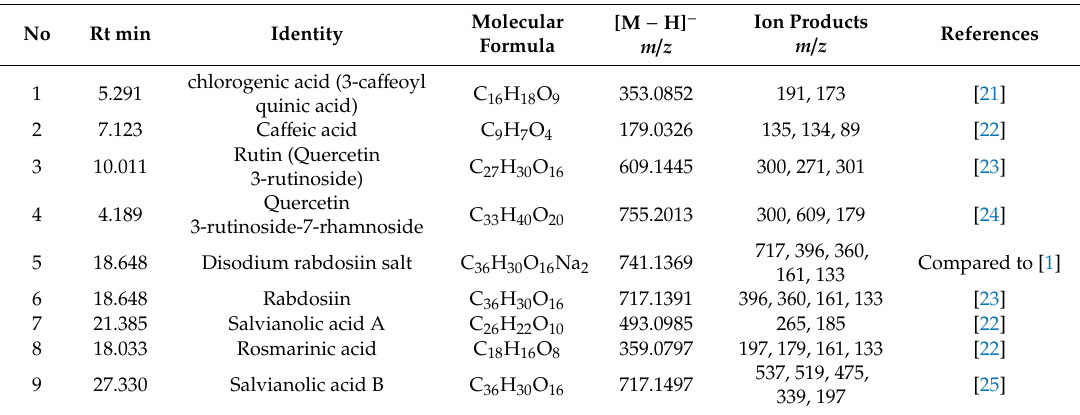
Table 1. LC / MS analysis of methanol extract of R. graeca